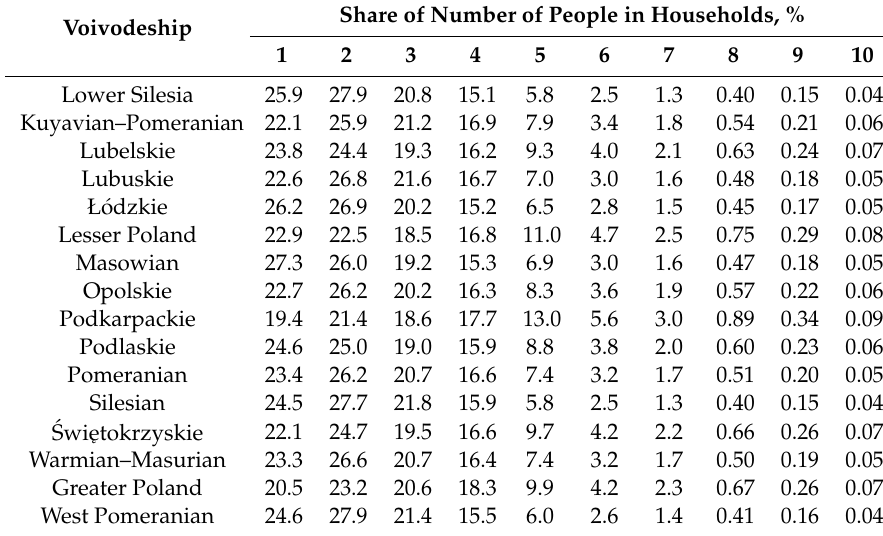
Table 2. Structure of the number of people in households in Poland. Source: own study based on [65]. Share of Number of People in Households, Voivodeship